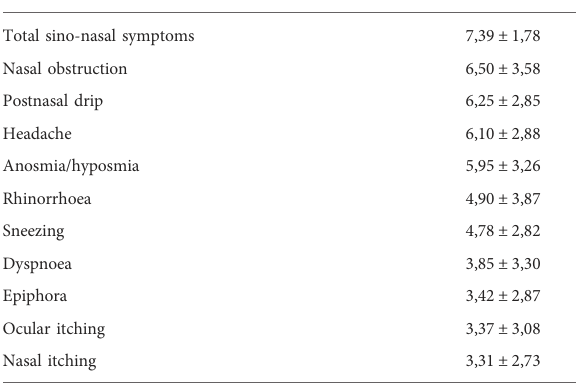
TABLE 2 Mean visual analogue (VAS) score.